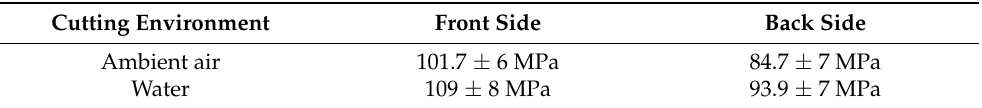
Table 3. Average characteristic strength of glass strips cut in ambient air and water for the front and back side bending cases. Strength was averaged in terms of hatch distance.